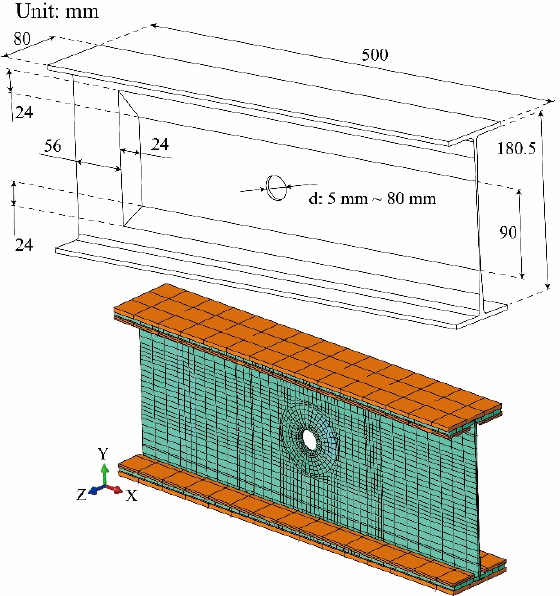
Figure 34. The FE models of the PWF composite beams with the centered open-hole and no reinforcement.